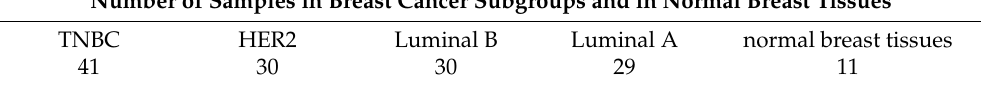
Table 1. Curie Cohort (Transcriptome Analysis): MEP50 mRNA Expression in Breast Cancer Sub- groups and Normal Breast Tissues (Figure 1).